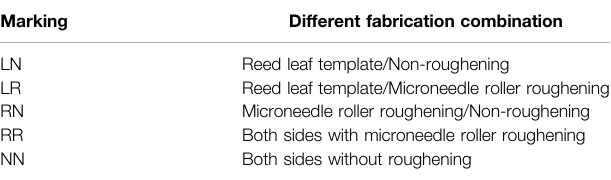
TABLE 1 | Process combination of the IPMC sensor